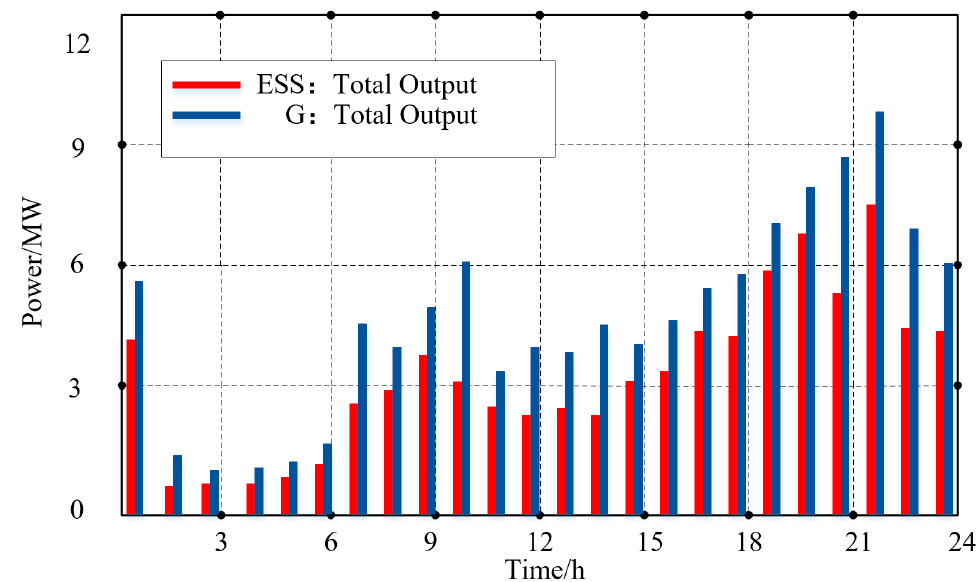
Figure 9. The output of traditional generations and storage units.